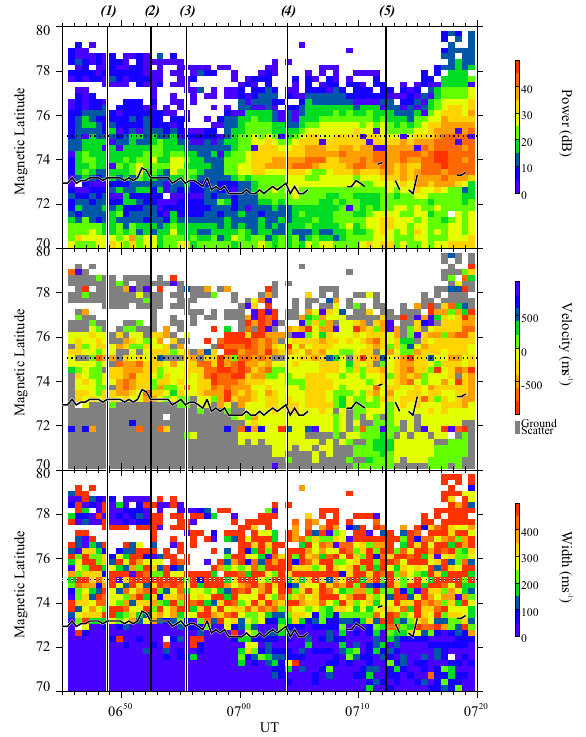
Fig. 4. The backscatter power (top panel), line-of-sight velocity (middle panel) and spectral width (bottom panel) measurements along beam 9 of the CUTLASS Finland radar for the time interval 06:45–07:20UT, between 70–80 ◦ magnetic latitude. The Doppler velocities are shown with negative (positive) values representing flow away from (towards) the radar, and grey regions indicating identified as ground scatter. Also shown on each of the panels is the poleward boundary of the lower band of enhanced emission recorded in the 557.7nm wavelength by the MSP, as described in Fig. 3, projected to an assumed emission altitude of 150km. The five vertical lines mark the onset times of the intense luminosity increases in the red line emissions noted from the MSP data. The horizontal dotted line represents the magnetic latitude of the